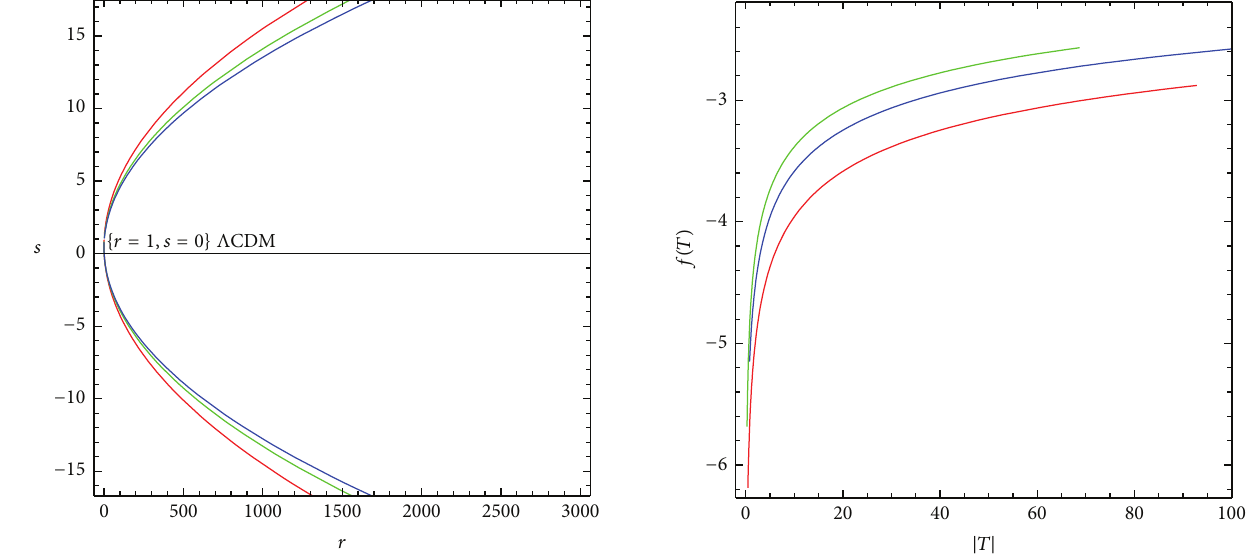
Figure 5: Statefinder parameters for the choice of 𝐻 = 𝐻 0 + 𝐻 1 /𝑡 . Figure 6: Plot of 𝑓(𝑇) based on reconstructed 𝐻